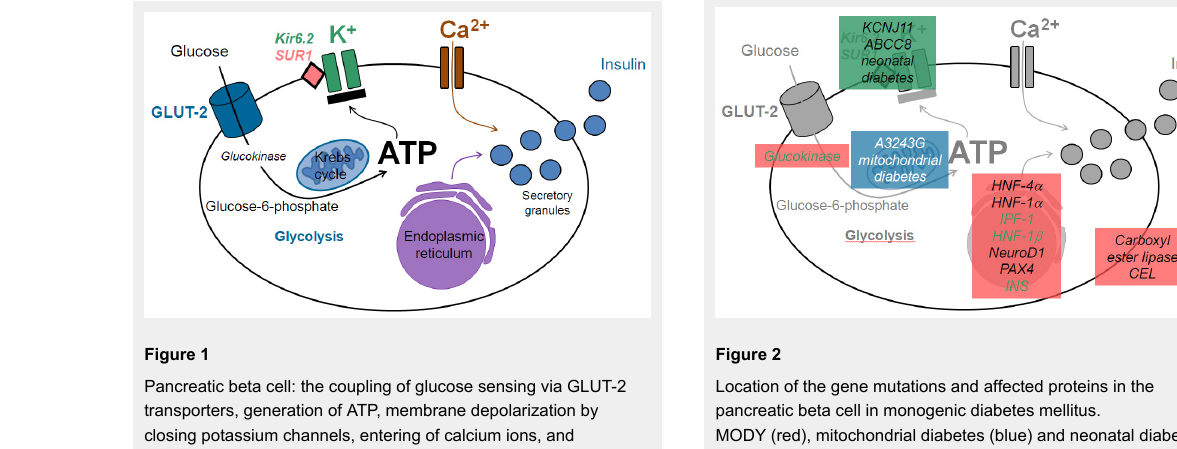
beta cell insulin secretion: glucose is transported into the